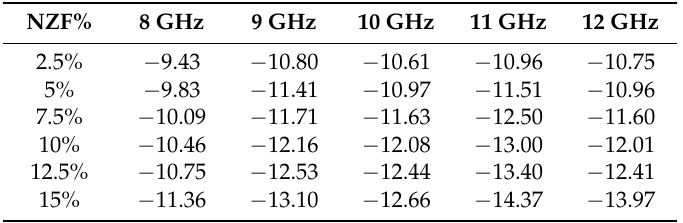
Table 5. Variation of reflection loss for NZF + OPEFB + PCL composites.